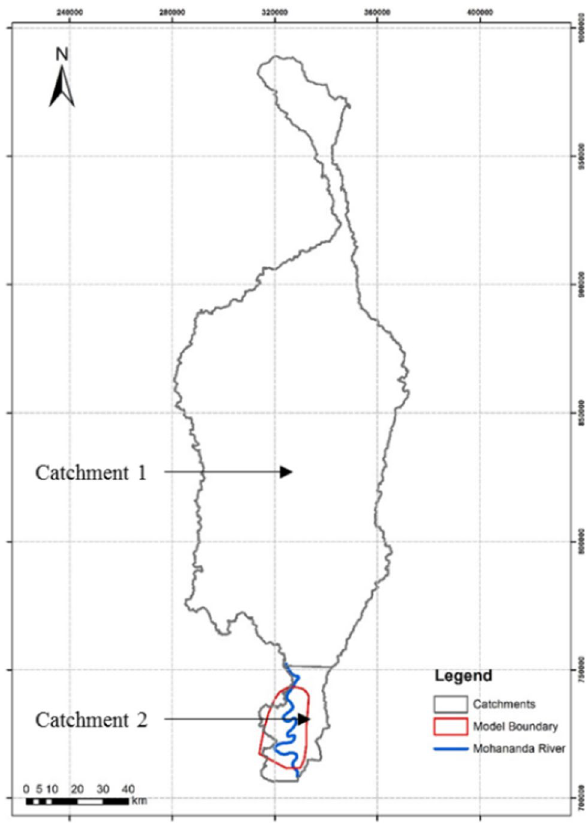
Fig. 3 Schematic diagram of the approach and methodology applied in the study. This work uses a river–groundwater integrated model developed using MIKE 11 and MIKE SHE to analyze the impact of storage reservoir facilitated surface water irrigation on the adjacent aquifer in the model area